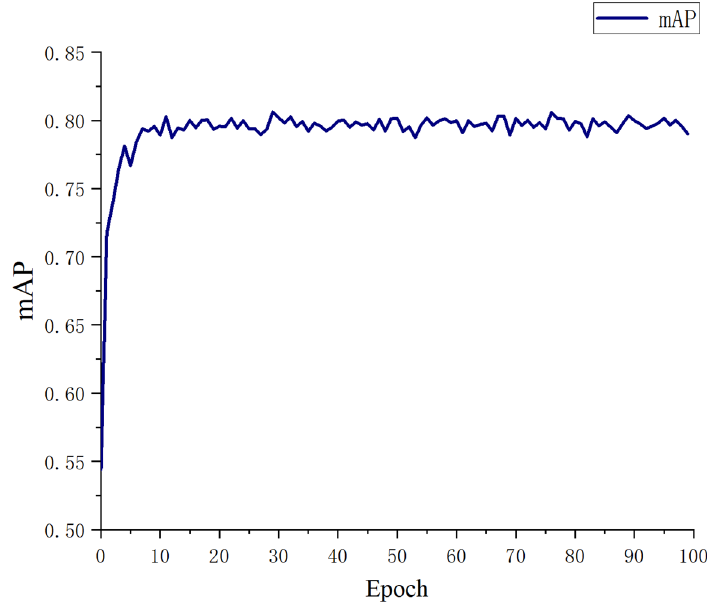
Figure 14. Changes in mAP during training.